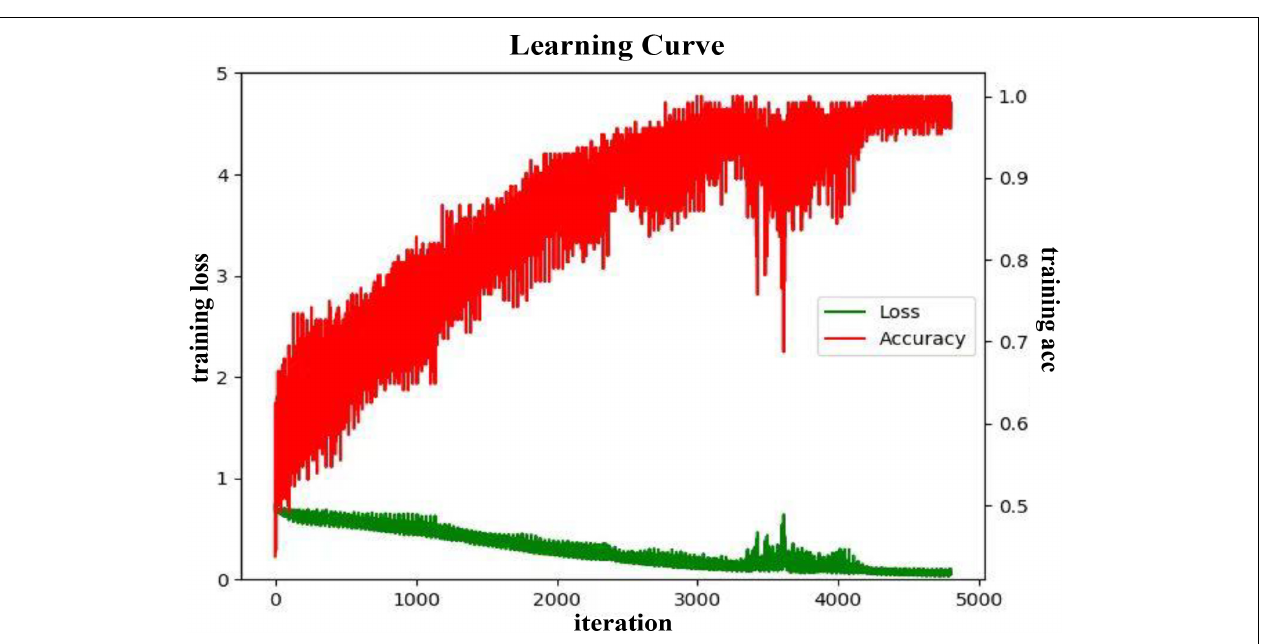
FIGURE 7 | The training process curve in the subject-independent experiment in the